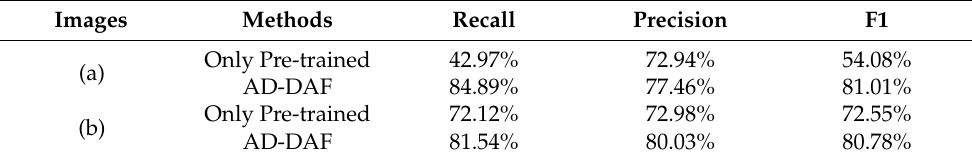
Table 2. The results of our framework with the UNet model on the two large areas.